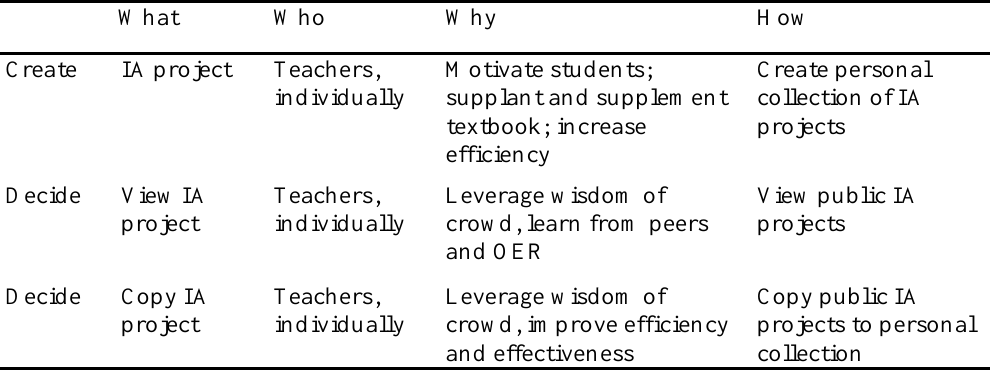
Create and Decide Dimensions from Malone et al. (2009) Applied to the Instructional Architect What Who Why How Create individually